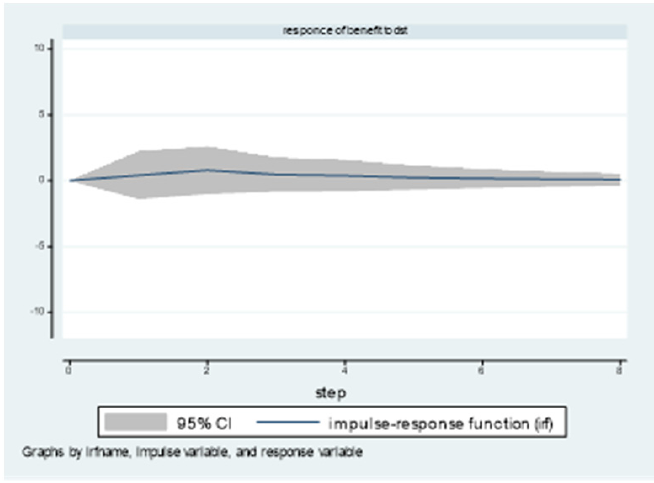
Figure 8. Response of power station revenue to space weather.